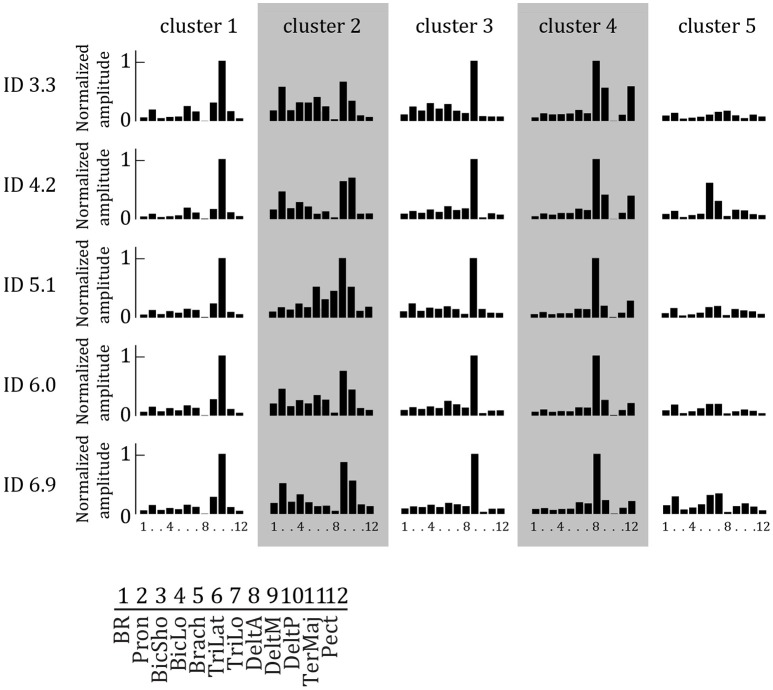
Synergy weights extracted by NNMF as a function of ID averaged per cluster. Per synergy, the normalized weight of each of the 12 muscles is represented. Each muscle is activated in multiple synergies. Higher bars indicate increased weight.